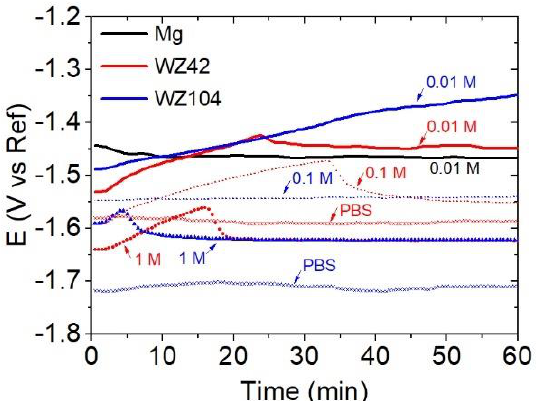
Figure 4. E OCP evaluation recorded for the investigated materials during 1 h of immersion in 0.01 M NaCl, 0.1 M NaCl, 1 M NaCl, and PBS.